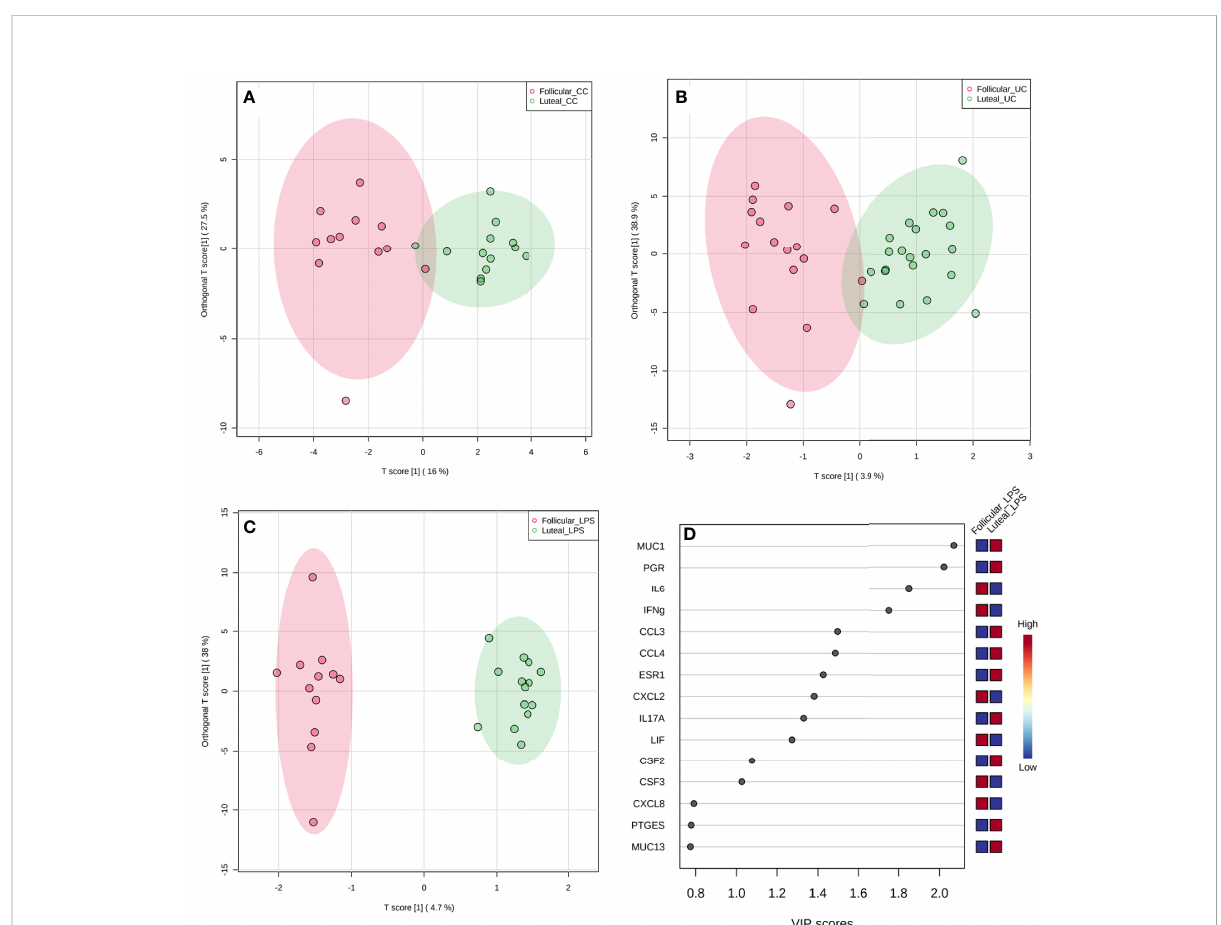
FIGURE 5 Overall gene expression clustering by OPLS-DA between follicular and luteal phase explants for uncultured control [ (A) ; UC; P = 0.001], cultured control [ (B) ; CC; P = 0.01], and LPS [ (C) ; P = 0.001] treatments with VIP plot (D) corresponding to LPS treatment clustering between